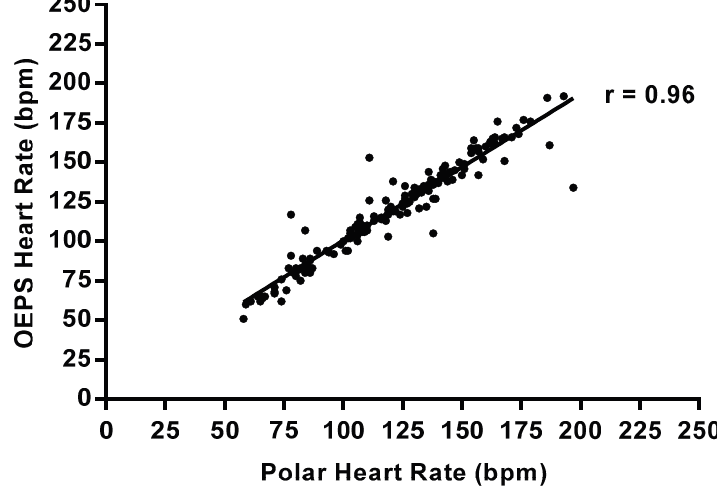
Figure 17. Correlation relationship between HR during rest and differing exercise modalities and intensities using Polar and the OEPS (r = 0.96, p < 0.0001).